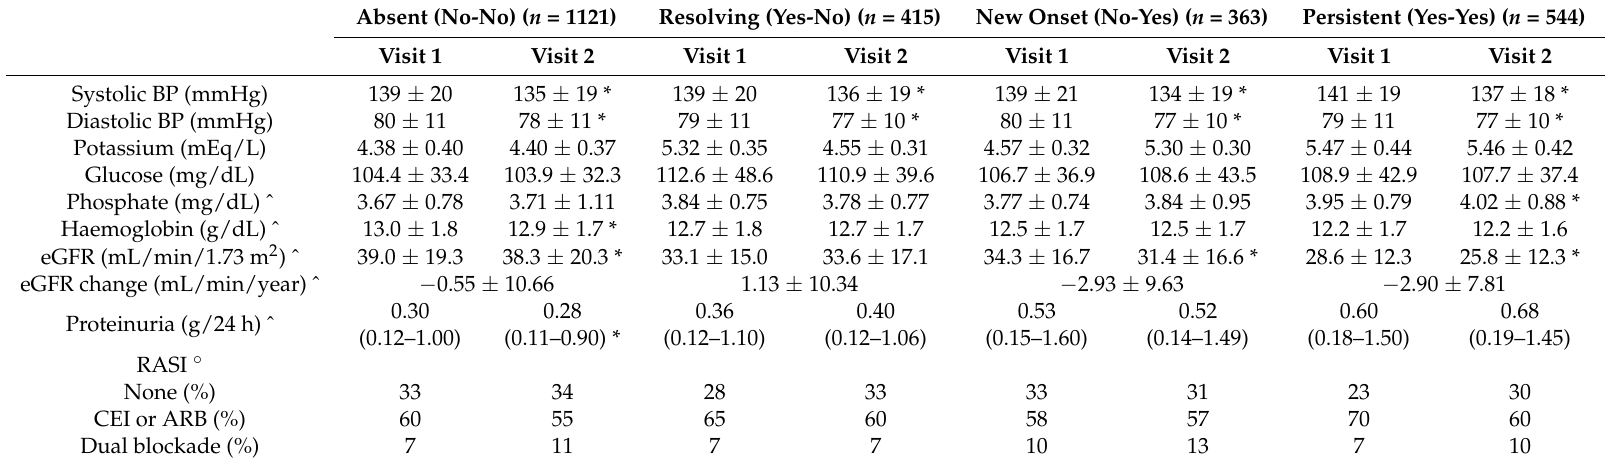
Data are mean ± SD or median (IQR) or percentage of patients. BP, blood pressure; eGFR, estimated glomerular filtration rate by EPI equation; RASI, renin angiotensin system inhibitors; CEI, converting enzyme inhibitor; ARB, angiotensin II receptor blocker. ˆ p < 0.05 for visit 1 and visit 2 among the groups. * p < 0.05 vs. Visit 1. ◦ RASI distribution differs between visit 1 and 2 for Absent and Persistent